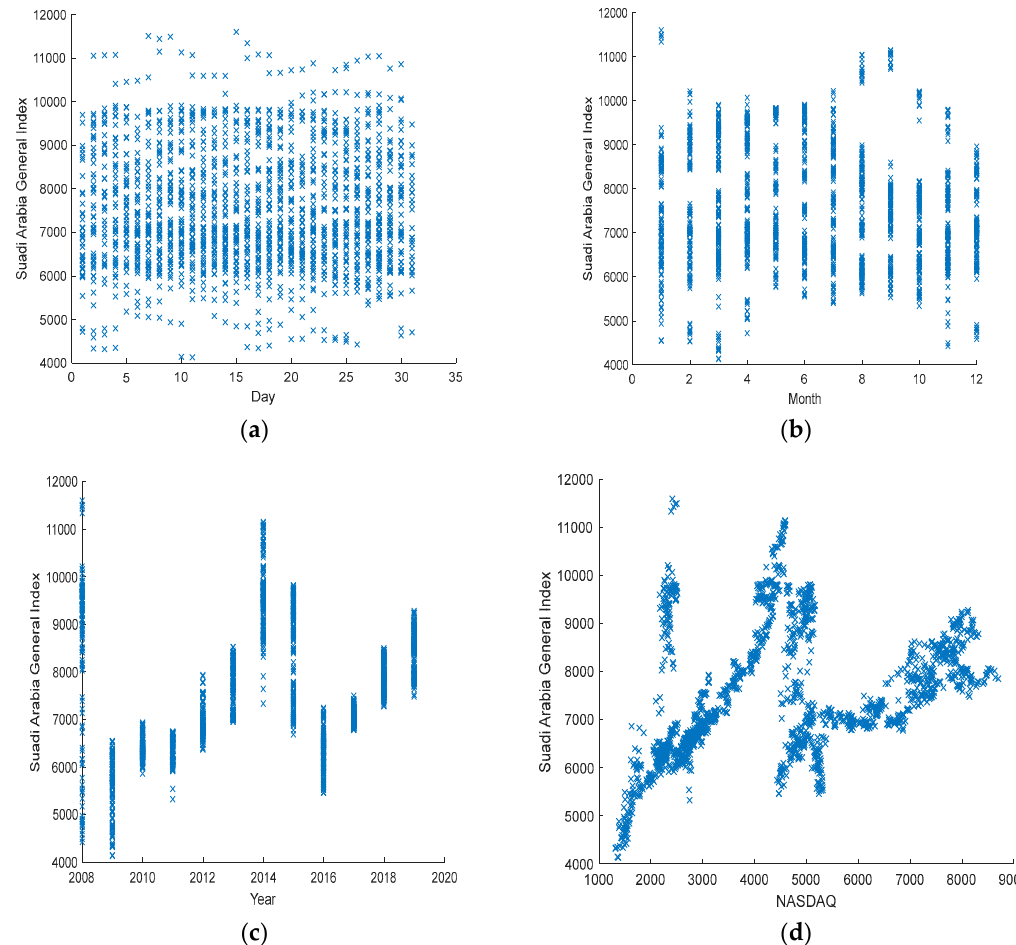
Figure 3. The relationship between Tadawul index (TASI) and ( a ) Day, ( b ) Month, ( c ) Year, and ( d ) NASDQ.